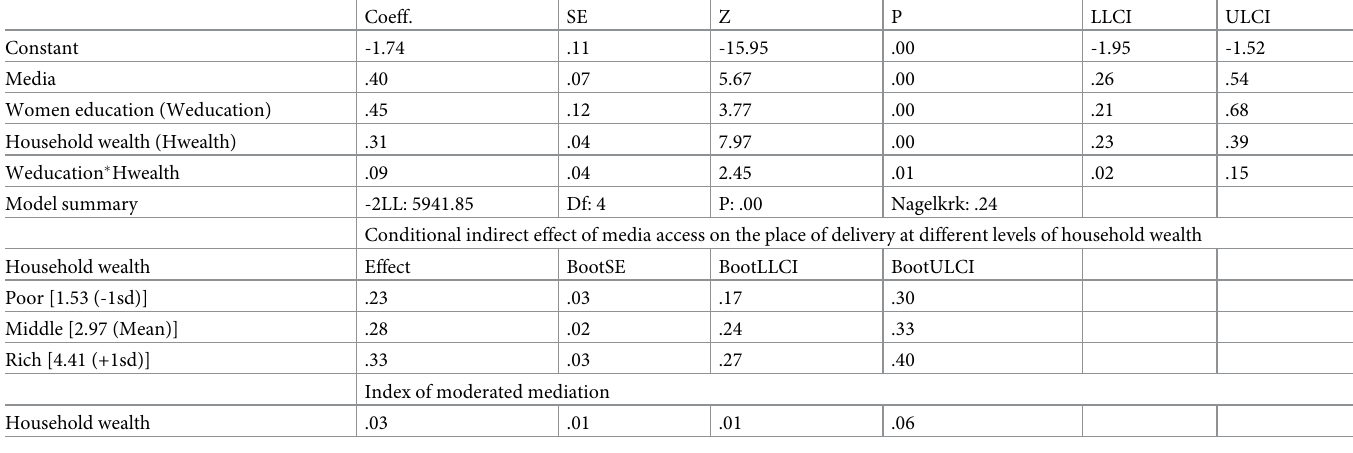
Table 6. Moderated-mediation model 1 (Media women education � household wealth delivery place).